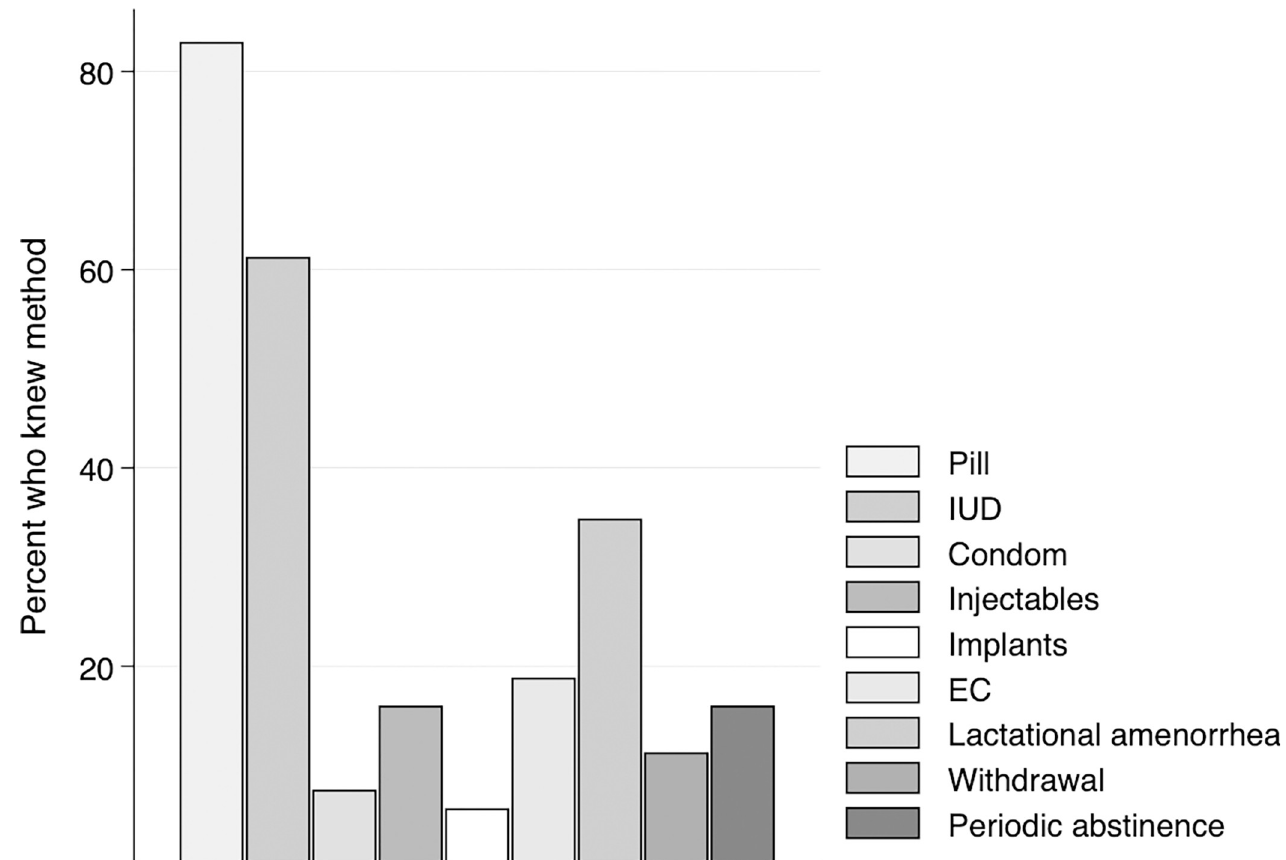
Fig 2. Knowledge of contraceptive methods among 15-17-year-old participants (N = 106). Note: IUD—Intra-uterine device; EC—emergency contraception.